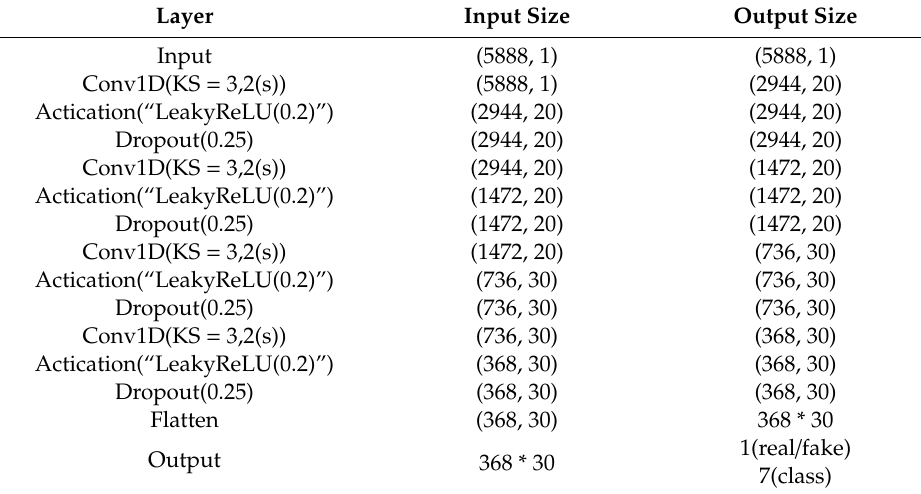
Table 2. The structure of discriminator in unidimensional